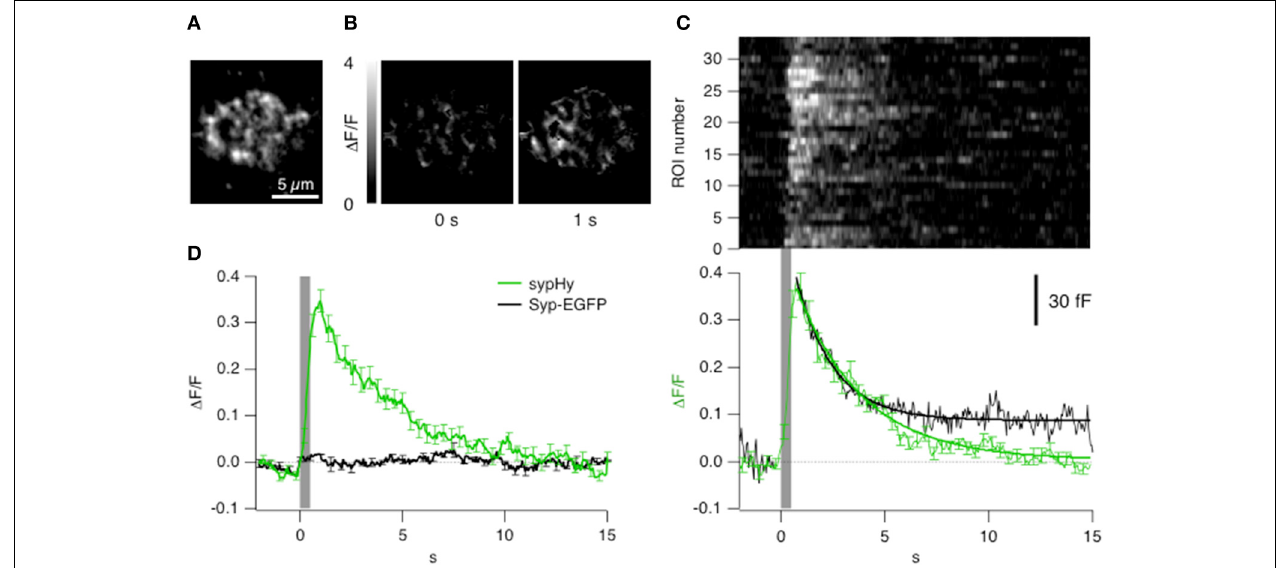
FIGURE 4 | Kinetics of vesicle fusion and retrieval observed with sypHy. (A) Average fluorescence projection (before stimulation) of TIRF image of the synaptic terminal of a bipolar cell expressing sypHy. (B) Images showing the relative changes in fluorescence at different time points from the start of a stimulus lasting 0.5s. These images have been backgroud subtracted and it was calculated the (cid:5) F / F (variation of fluorescence to the F0 = basal fluorescence). (C) Top: Raster plot showing the kinetics of the sypHy signal in 33 ROIs from the footprint in (B) . Note the variability in time-course of